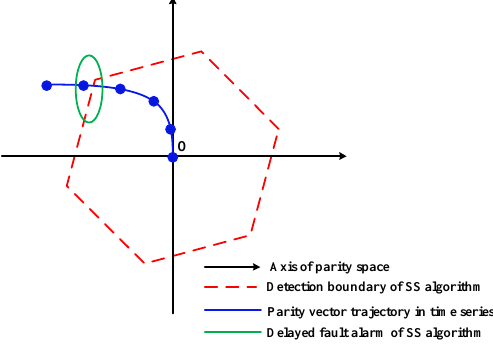
Figure 2. The extracted feature vector series in the parity space.